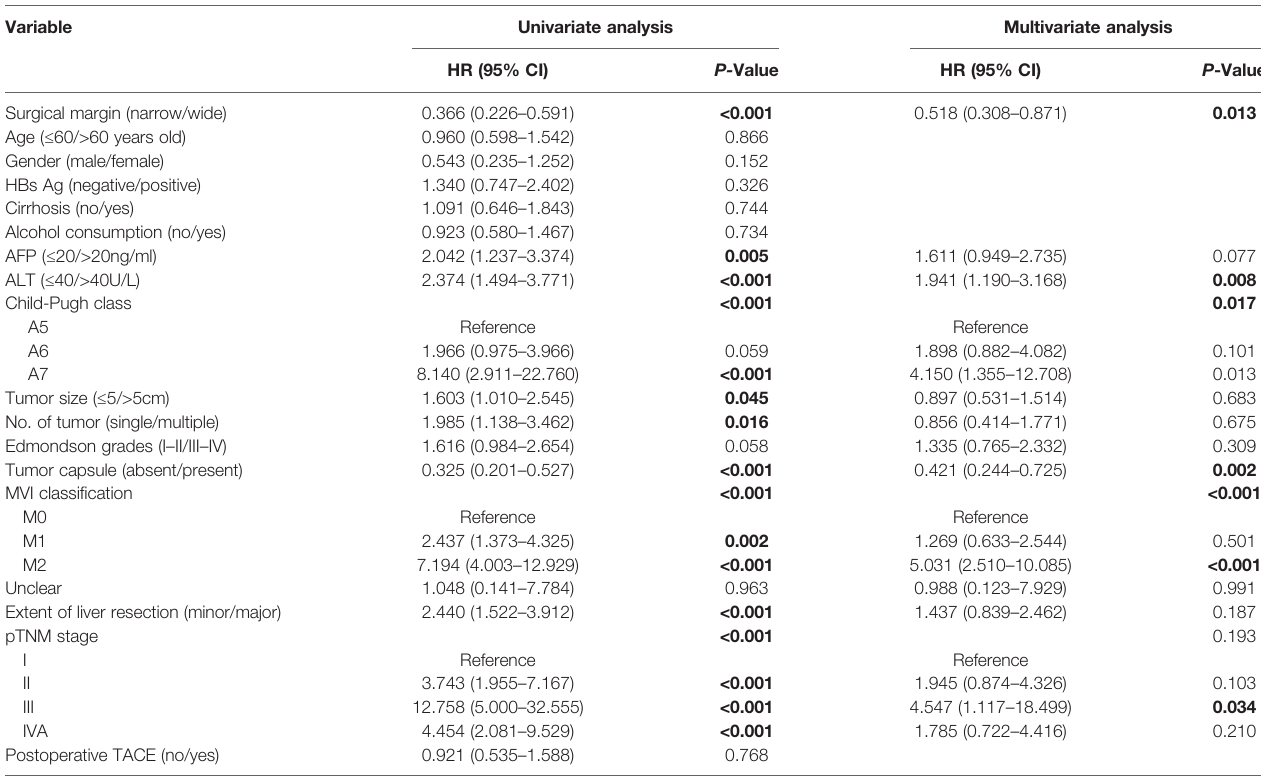
Surgical resection, tumor number, tumor size, and variables with p value <0.01 in the univariable Cox analyses were retained for the multivariable Cox analysis. The foreparts of the parentheses were set as the reference groups in the univariable and multivariable Cox analysis. HBsAg,hepatitisBsurfaceantigen;AFP,alpha-fetoprotein;ALT,alanineaminotransferase;MVI,microvascularinvasion;pTNMstage,pathologicTNMstage;TACE,transcatheterarterial chemoembolization. P < 0.05 was indicated by bold